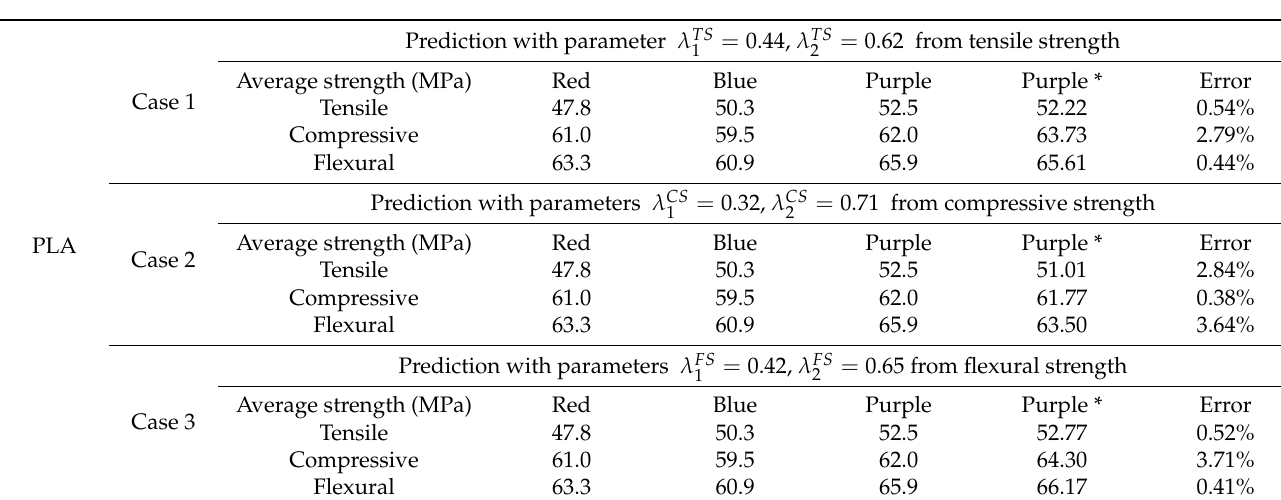
Figure 9. Mechanical strengths for different materials: ( a ) PLA and ( b ) ABS. Table 4. Predicated mechanical strengths for PLA samples in red, blue and purple